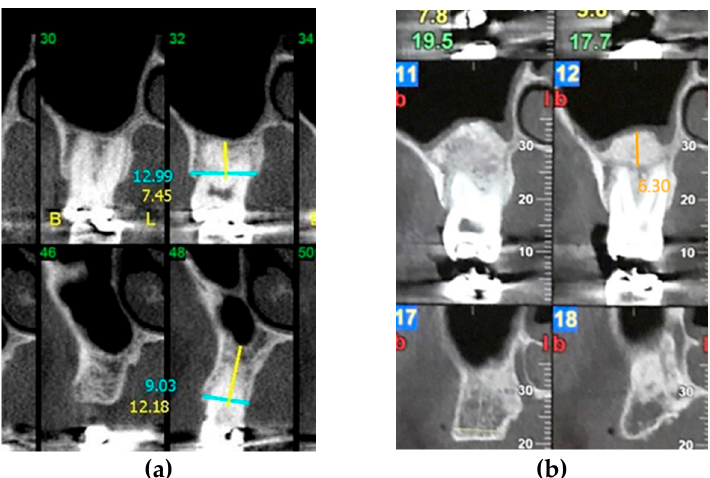
after augmentation (slice 8). Appl. Sci. 2020 , 10 , x FOR PEER REVIEW ( b ),